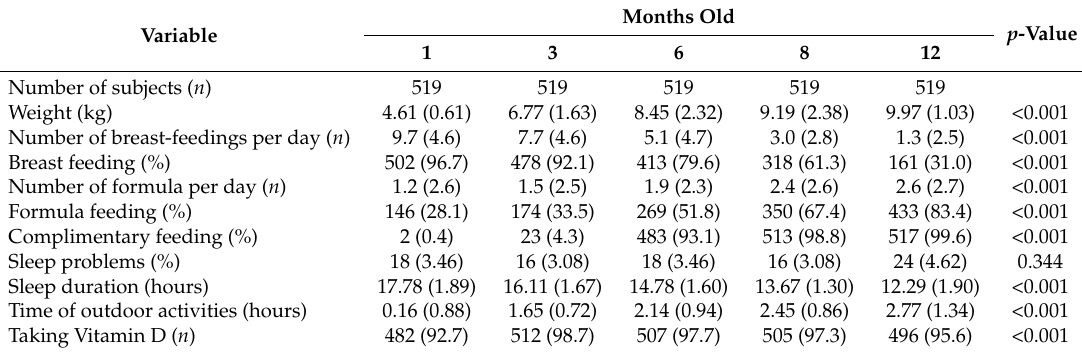
Figure 1. Prevalence of malnutrition, normal weight, overweight, and obesity infants aged 0–12 months old in Changsha, China in 2013. Table 3. The characteristics of the subjects in each time point based on panel data 1 (According to longitudinal community-based retrospective birth cohort study conducted in Changsha in 2013–2014).